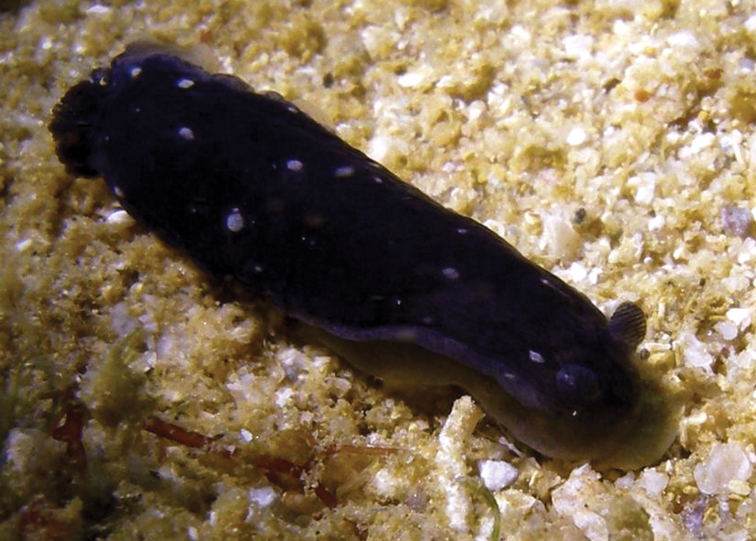
Dendrodoris nigra, Oman, photo: S Kahlbrock (no spcm).